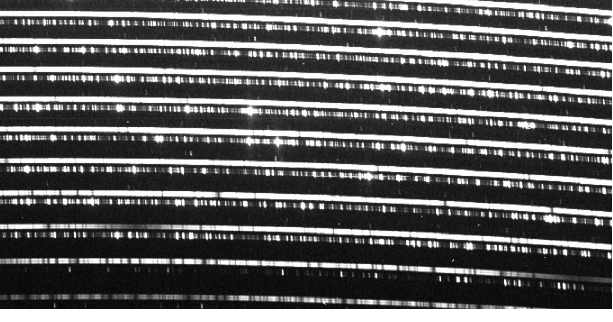
Fig. 21.— Region within a raw image of a spectrum of the star HIP66974 and a calibration lamp, taken with ESO’s FEROS spectrograph in June 2015 (Data set SAF+FEROS.2015- 06-13T23:16:46.772). Retrieved from ESO’s Science Archive on 24 April